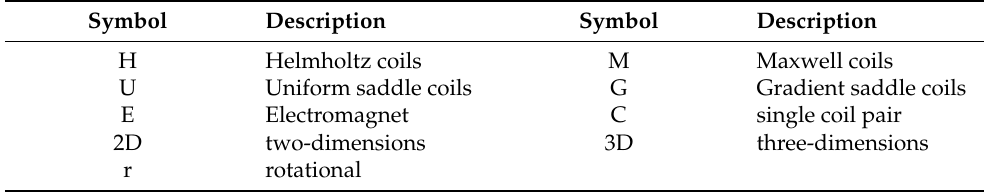
Table 1. ElectroMagnetic Actuation system nomenclature.